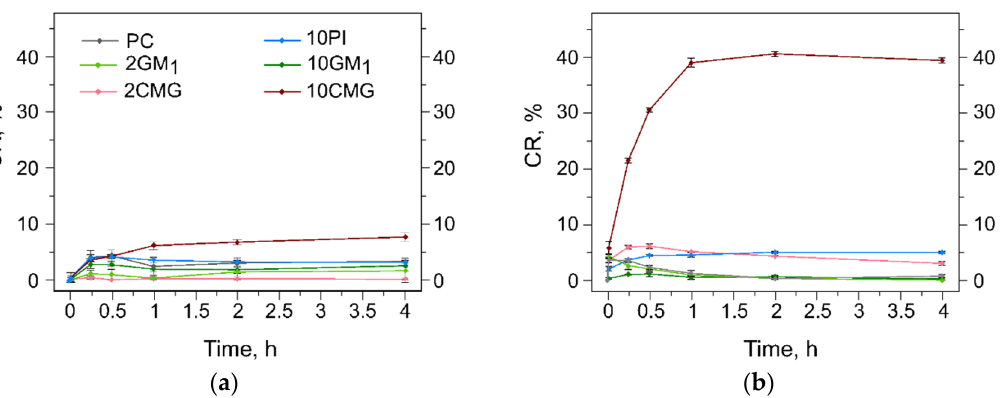
Figure 4. ( a ) Calcein release (CR, %) from liposomes upon incubation in PBS at 37 °C in the absence of albumin; ( b ) calcein release (CR, %) from liposomes upon incubation in PBS at 37 °C in the presence of BSA 40 mg/mL. Means ± SD (n = 3) are presented.